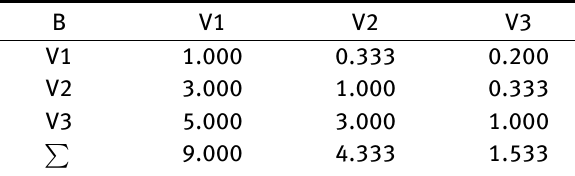
Table 11: Comparison of variants in accordance with